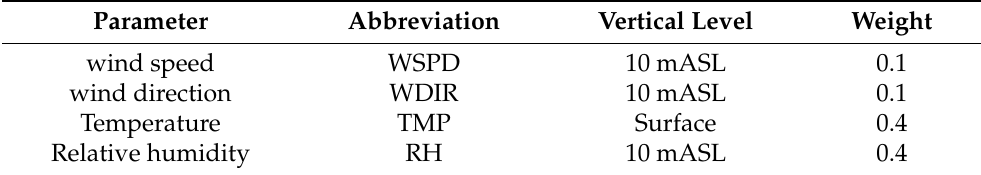
Table 1. NAM-NMM predictor variables used in the